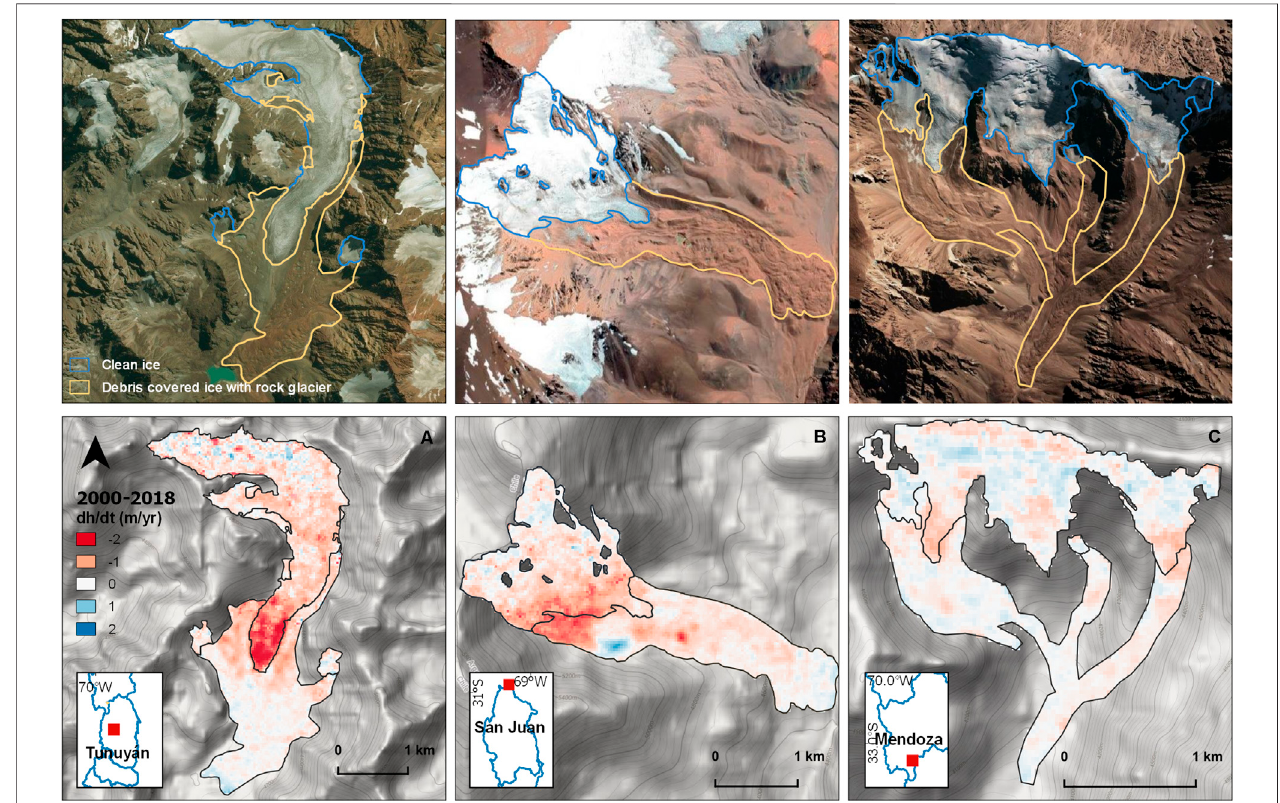
FIGURE 9 | Different examples of “ debris-covered ice with rock glacier ” category (upper row) in (A) Tunuyán, (B) San Juan and (C) Mendoza basins and the corresponding rate of elevation changes from 2000 to 2018 (lower row).